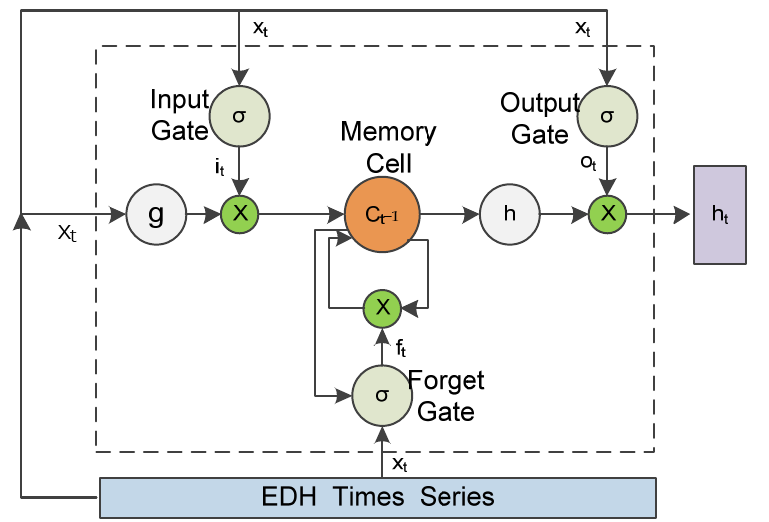
Figure 5. Structure of the LSTM memory unit.